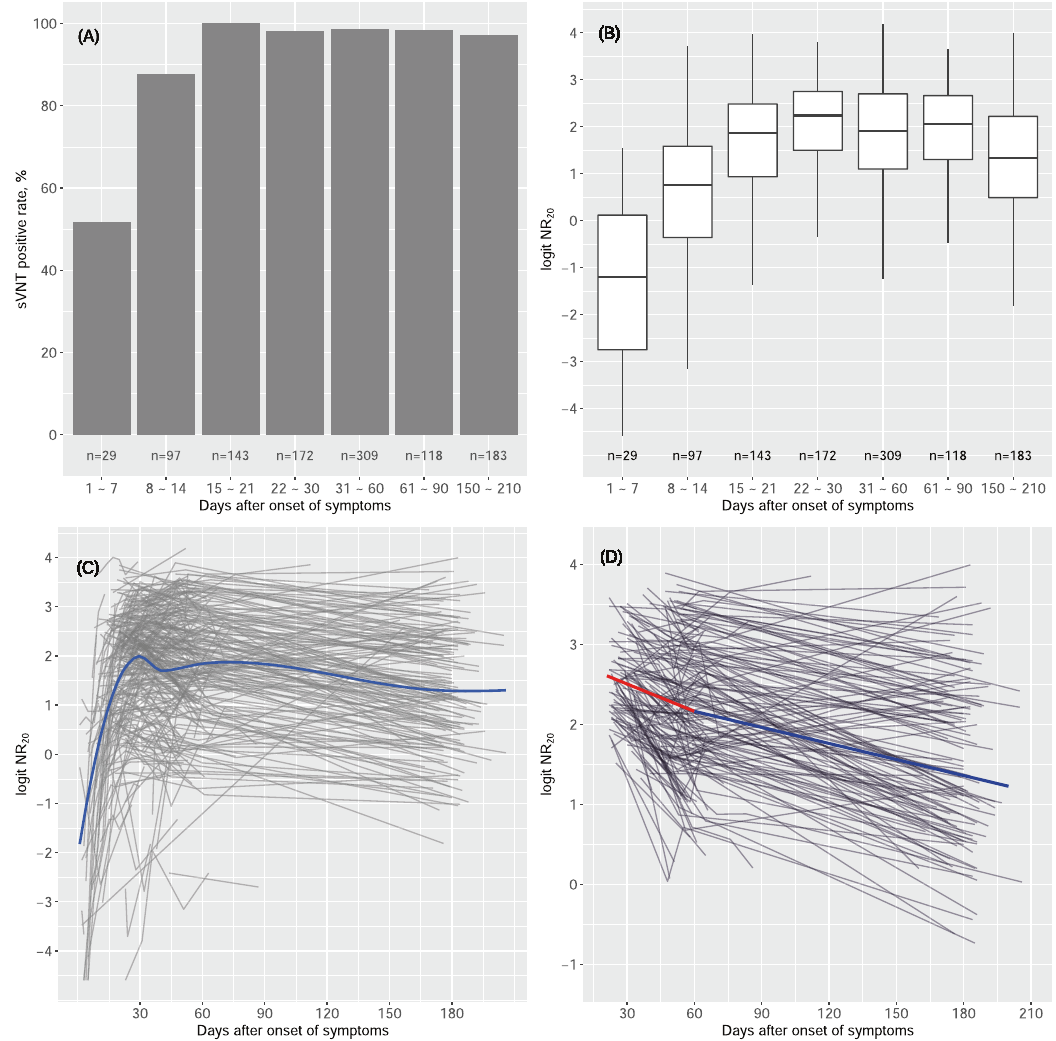
Fig. 2 Dynamics of NAbs response to SARS-CoV-2. A The positive rate of NAbs (measured by sVNT) strati fi ed by time post onset. A NR 20 value (neutralization rate at 1:20 sample dilution) of ≥ 20% was regarded positive. B Boxplot of the titers of NAbs strati fi ed by time post onset. C The trajectories of NAbs in patients. Each gray line represents the trajectory of a patient. The blue line is the loess smooth curve of the trajectories. D Decline of NAbs over time in patients with peak logit NR 20 > 1.3 (25 th percentile of peak distribution). Each gray line represents the post-peak trajectory of a patient. The blue line is the loess smooth curve of the Supplementary Table 1) and were used for exploring the association between the clinical features of COVID-19 and the peak level of NAbs (logit NR 20 ). A total of 57 demographic and clinical features were analyzed, including age, gender, disease severity and duration of COVID-19 (days from onset to the earliest- time RT-PCR testing turning from positive to negative), presence